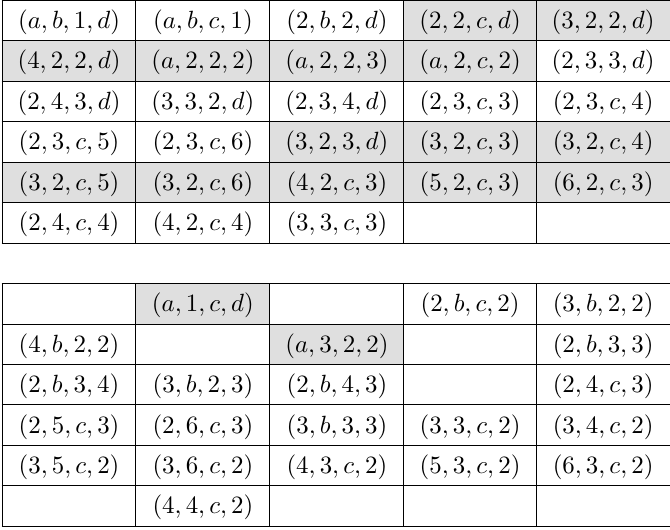
Table 10 . Infinite sequences of type VII singularities. The second table is obtained from the first by exchanging b, d . Gray entries are reducible to previous types of singularities or b = 1 . This table is adapted from